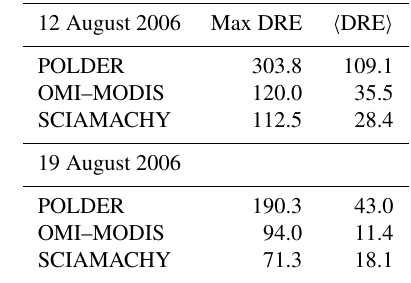
Table 2. Maximum and average values of OMI–MODIS, SCIA- MACHY and POLDER DRE on 12 and 19 August 2006 for the areas shown in Fig. 1a–f. The angled brackets denote the averaged values described in the